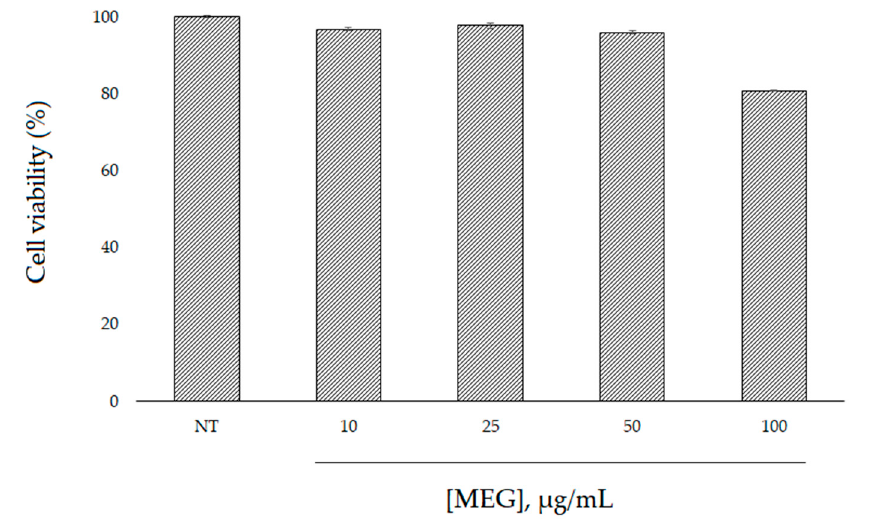
Figure 4. Effect of MEG on HaCaT cell viability. Cell viability was determined by an MTT assay after 24 h of incubation with the extract at different concentrations. 24 h of incubation with the extract at different